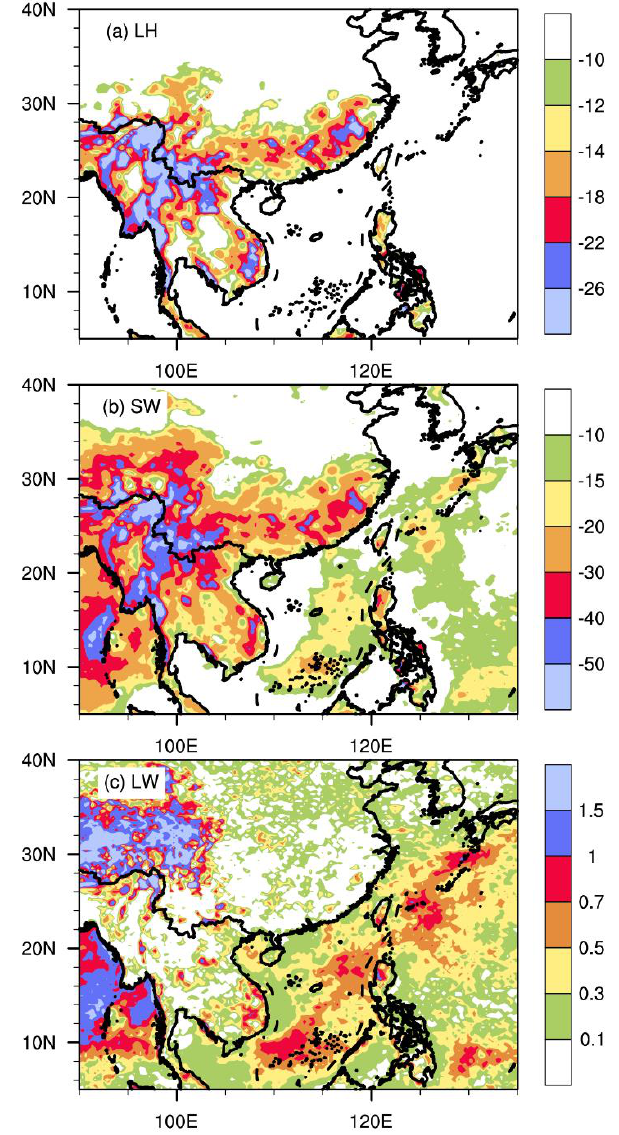
Figure 9. JJA average differences (unit: W/m 2 ) due to ADE (CTL-SEN test) in ( a ) latent heat flux, ( b ) downward shortwave radiation flux, and ( c ) downward longwave radiation flux.